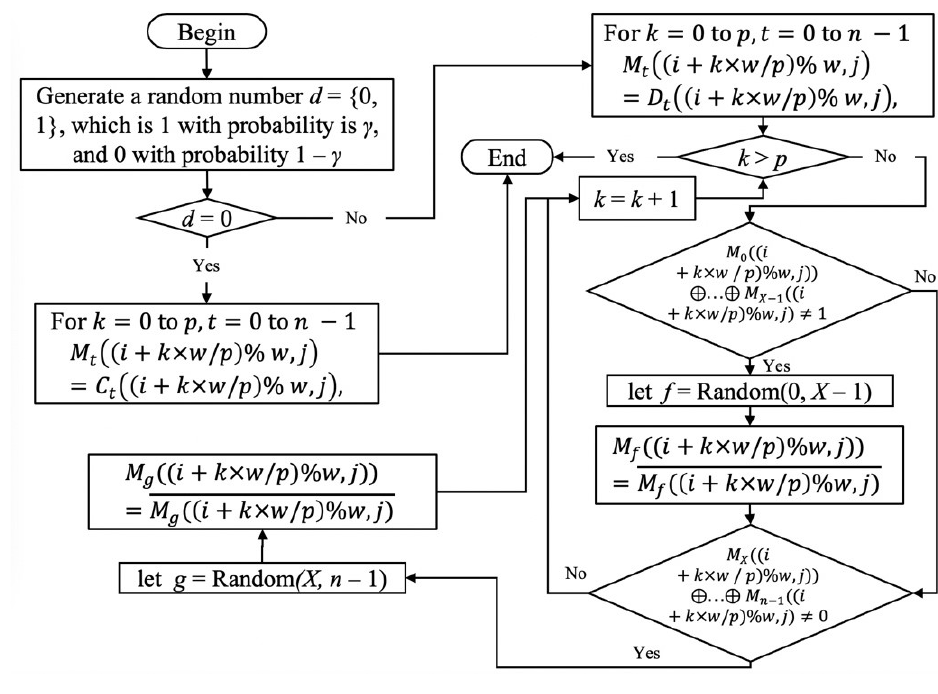
Figure 11. Process chart of Method 4 Steps 1–3.